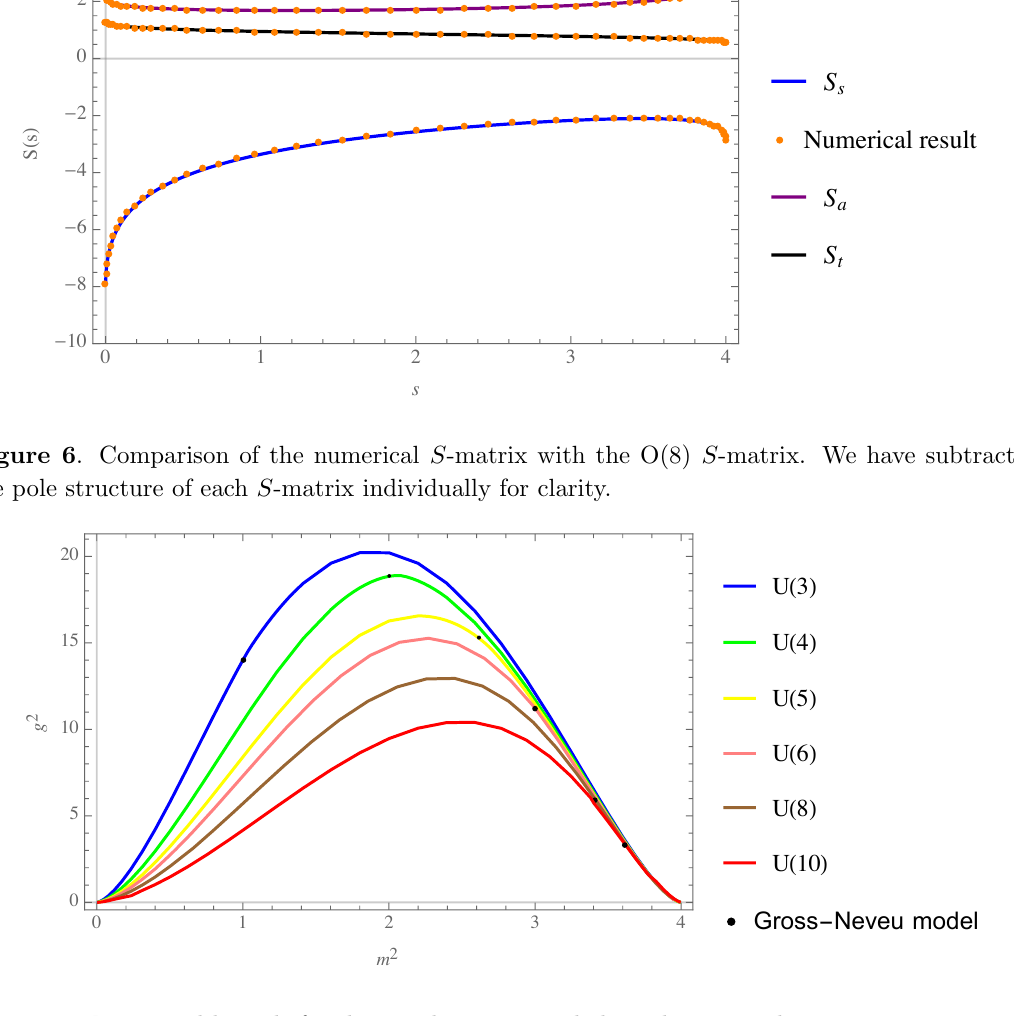
Figure 7 . Numerical bounds for the coupling to a single bound state in the antisymmetric tensor channel. The Gross-Neveu model saturates the bound for all N we